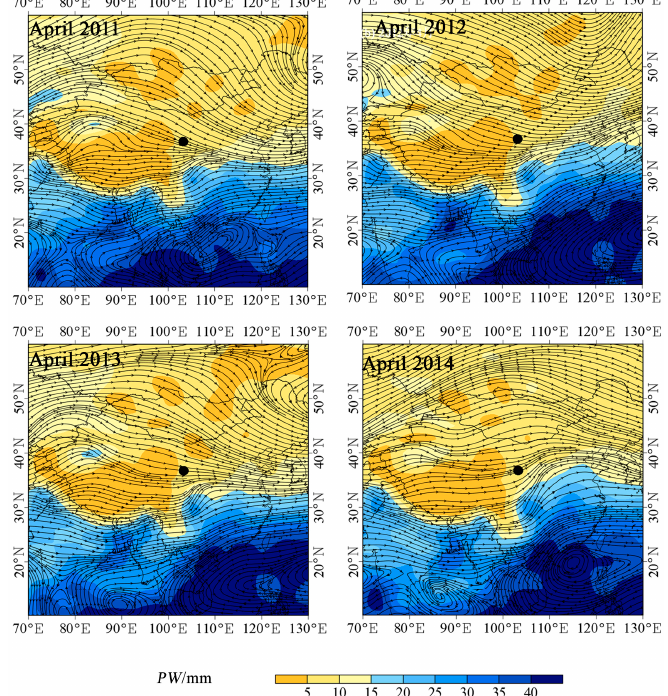
Figure 7. Water vapor stream and precipitable water amount ( PW ) surrounding the study region in April for different years.